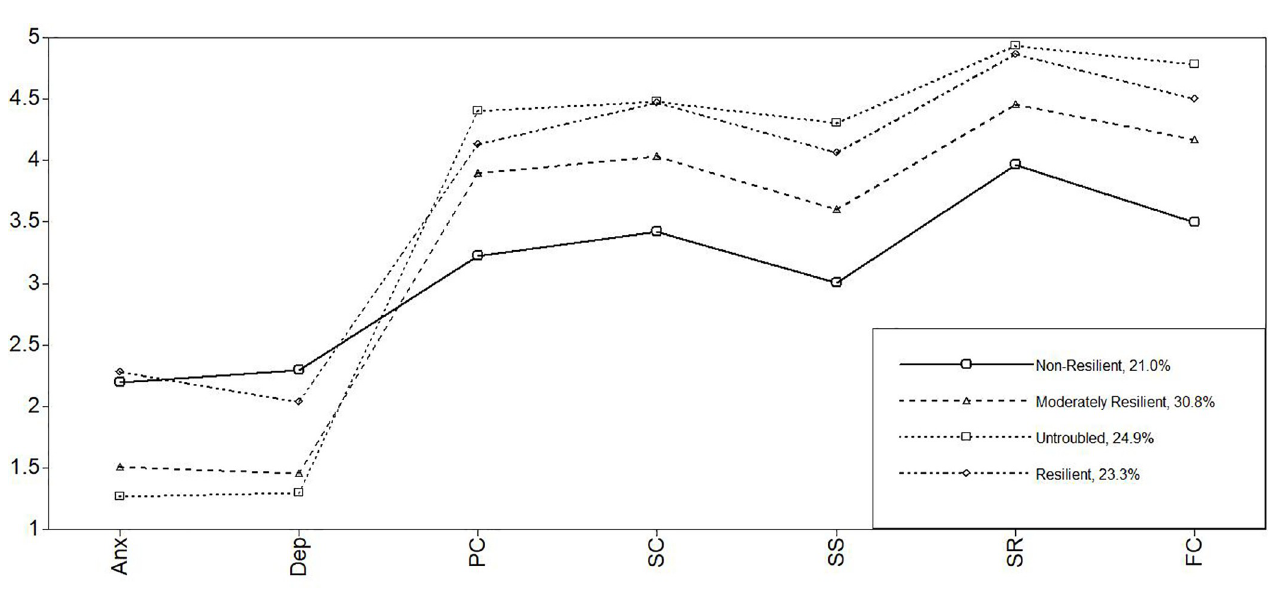
PLOS ONE | https://doi.org/10.1371/journal.pone.0263089 January 27,